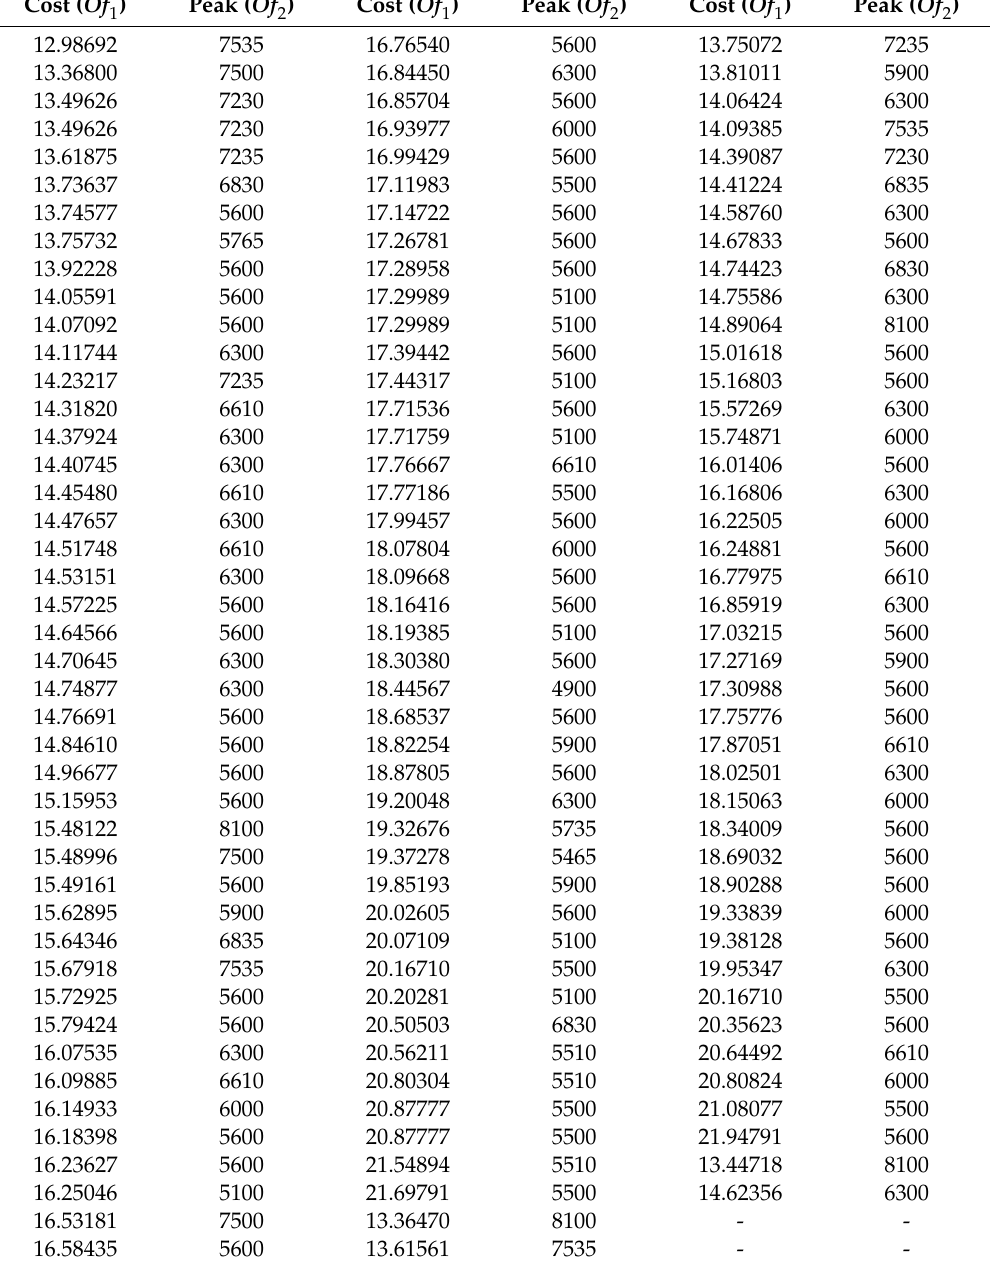
Table 6. Optimal Pareto front solutions of the multi-objective optimization di ff erential evolution (MODE)